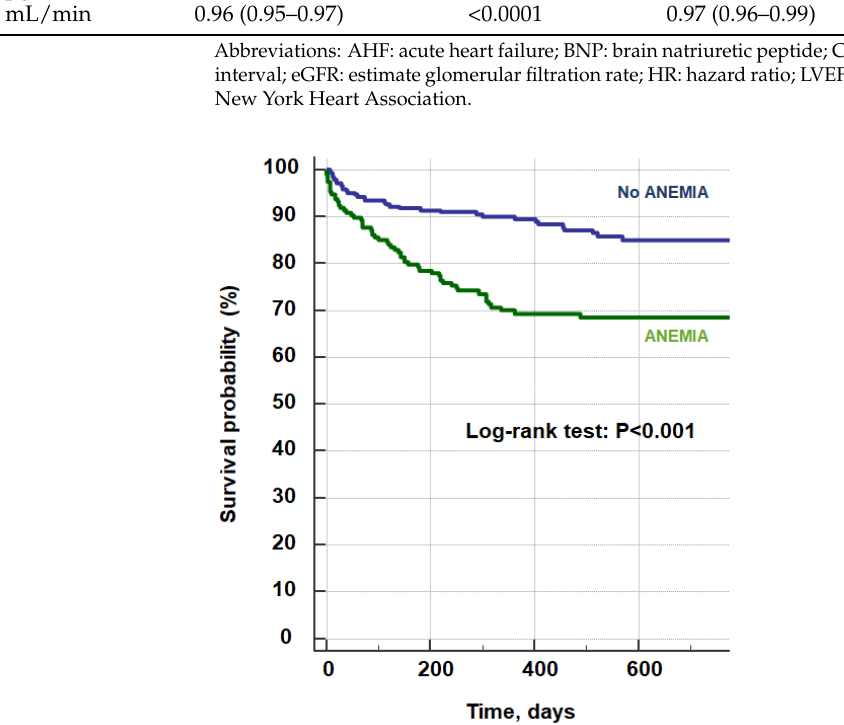
Figure 3. Kaplan–Meier survival curves stratified for the absence or presence of anaemia.